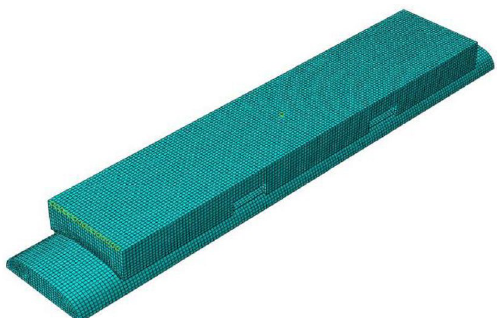
Figure 3 Mesh model of sand belt—rail—grinding